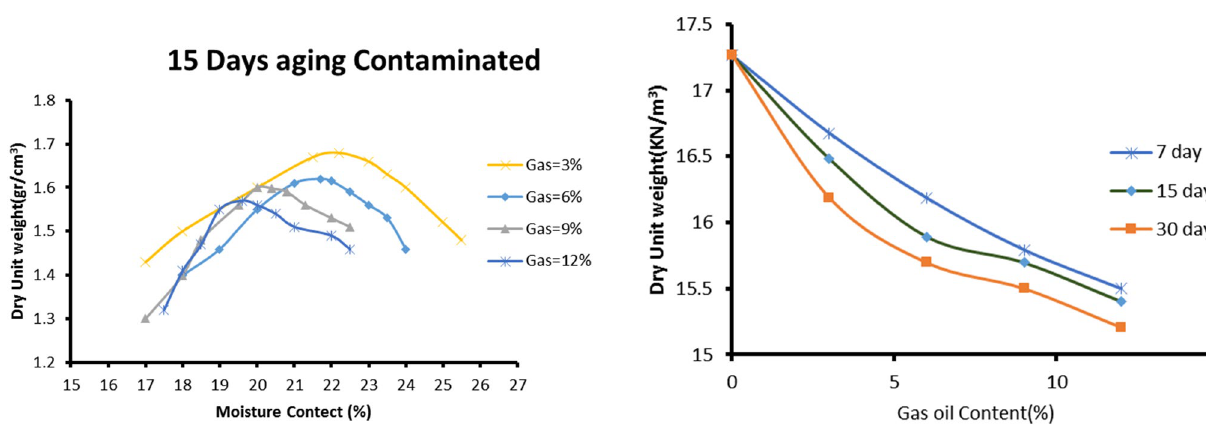
Fig. 11 Maximum dry density changes in 7-day contamination and different percentages of gasoline